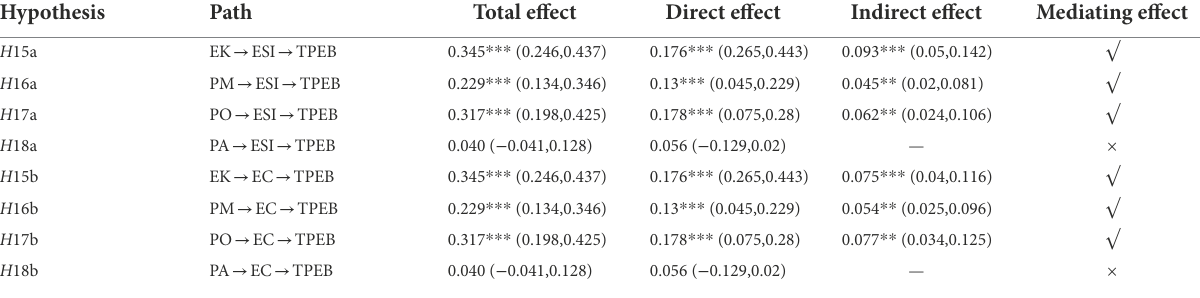
TABLE 7 Summary of mediating effect